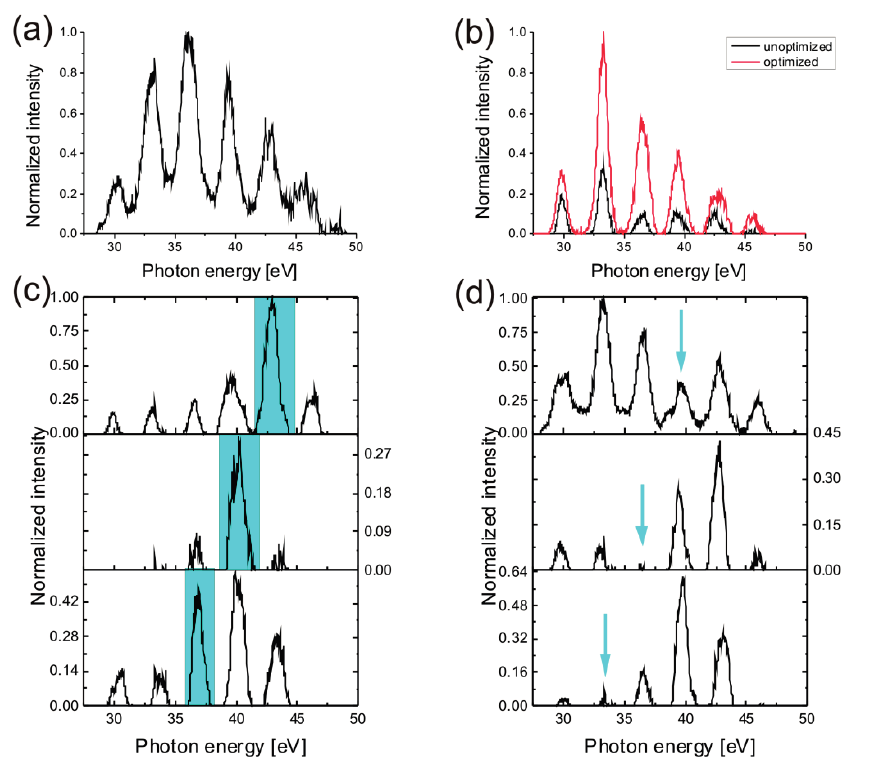
Figure 5. Different optimization goals for pulse-shaping experiments in HHG experiments. ( a ) is a typical HHG spectrum from a hollow-core fiber with a pulse that is compressed by translating the prisms for highest XUV yield and using a flat mirror surface; ( b ) shows an optimization of the overall yield by adaptively shaping the deformable mirror. By temporally shaping the driving laser pulse, a specified region of the spectrum (blue area) can be enhanced ( c ) or suppression of harmonics (blue arrows) can be achieved ( d